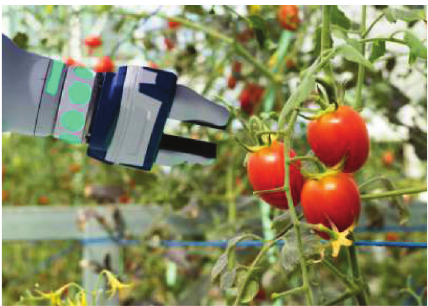
Figure 3: Robocrop picking fruits